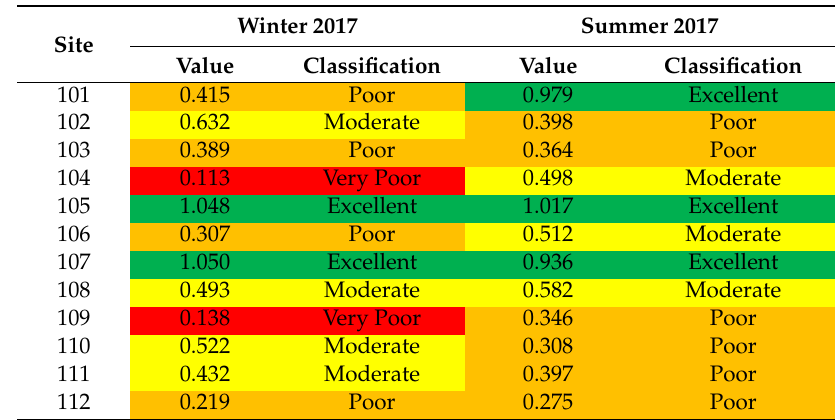
Table 2. IPtI N values and classification for the twelve measurement sites for winter and summer of 2017. An identification color was linked to each class that shades the corresponding cells: red—Very Poor, orange—Poor, yellow—Moderate, green—Excellent. The shades were added to the table for illustration and prompt interpretation of the quality